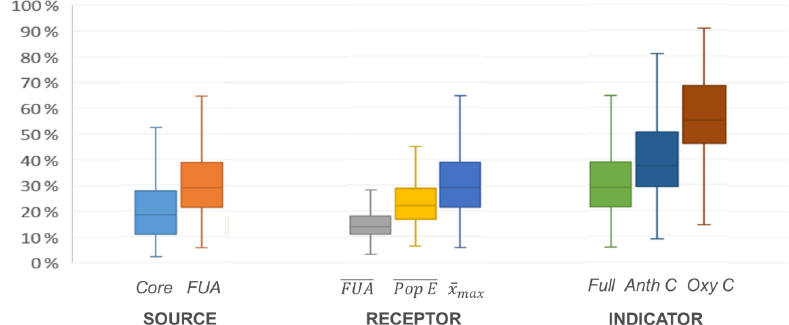
Figure 8. Box quantile diagrams summarizing the city contributions to PM 2 . 5 levels for the 150 EU cities. All results are based on a similar method (potential impacts at 50%) and a similar temporal receptor ( Y ) but for different choices of city sources (left), receptors (centre), and indicators (right). See previous sections for details. The two extremities of each vertical line represent the 10th and 90th percentile contributions among the 150 cities, respectively. The box crossing the horizontal line represents the